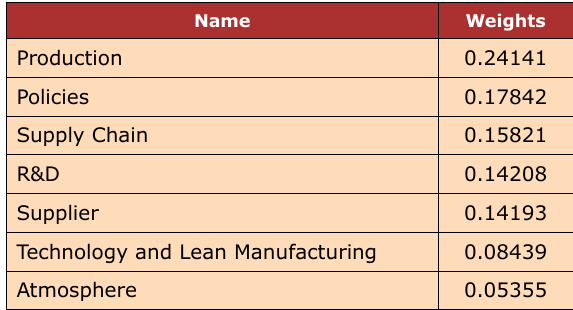
Table 8. Manufacturing Performance Indicators